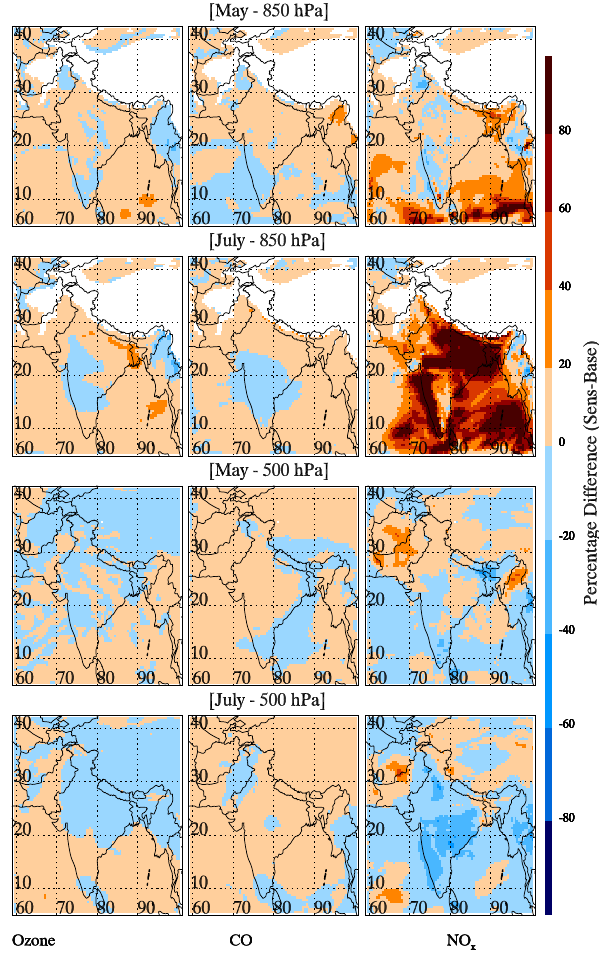
Fig. 15. Spatial distributions of percentage differences in ozone, CO and NO x at 850 and 500hPa between sensitivity and base model runs during May and July 2008. White space in the top two panels indicates the regions of surface pressure lower than